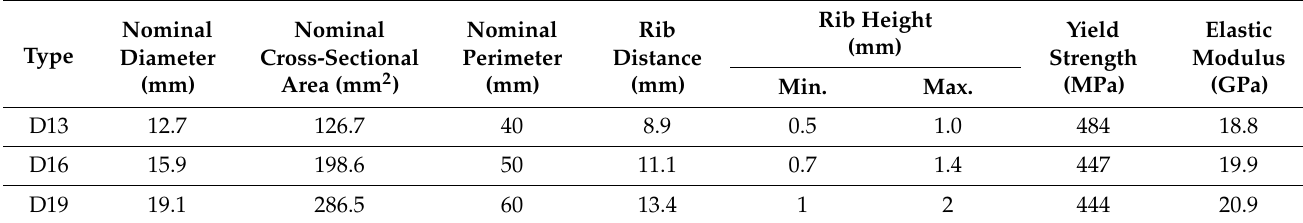
Table 4. Properties of steel